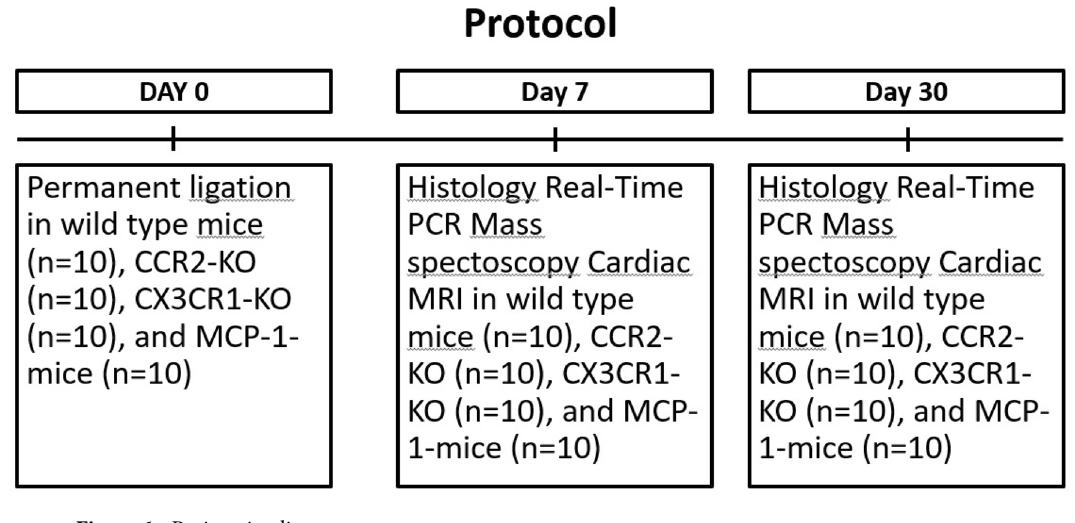
Figure 6. Project